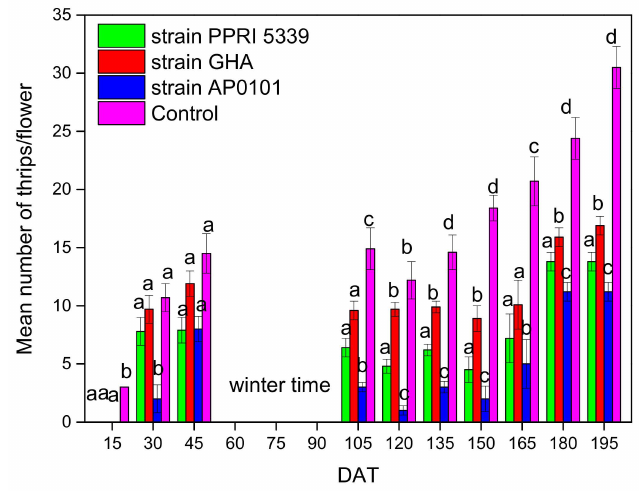
Figure 4. The average number of F. occidentalis adults per flower on Fragaria sp. plants inoculated with B. bassiana . Each treated plant was watered with 10 mL of 10 8 conidia/mL suspension at the stage of four leaves (November 2021), and after 4 months (March 2022), 25 flowers were sampled and examined from each treatment plot; only adults were counted, means of the same DAT marked with the same letter did not differ significantly (Tukey-Kramer test, p < 0.05); DAT: days after treatment.